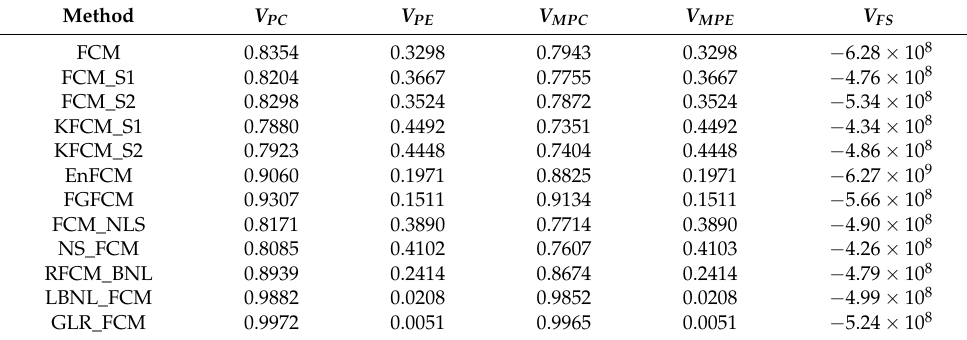
Table 5. Quantitative evaluation of the second simulated SAR image.